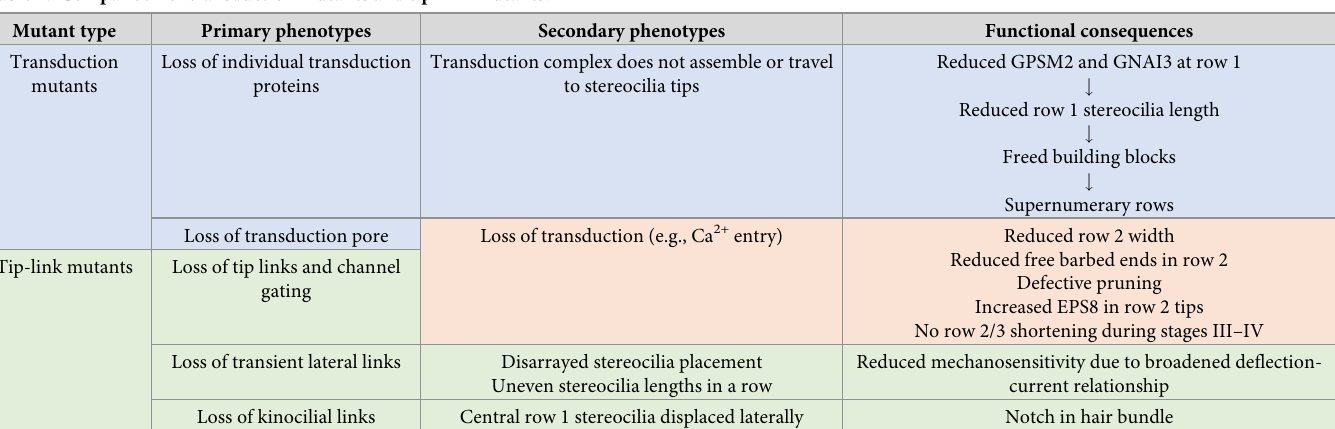
Table 1. Comparison of transduction mutants and tip-link